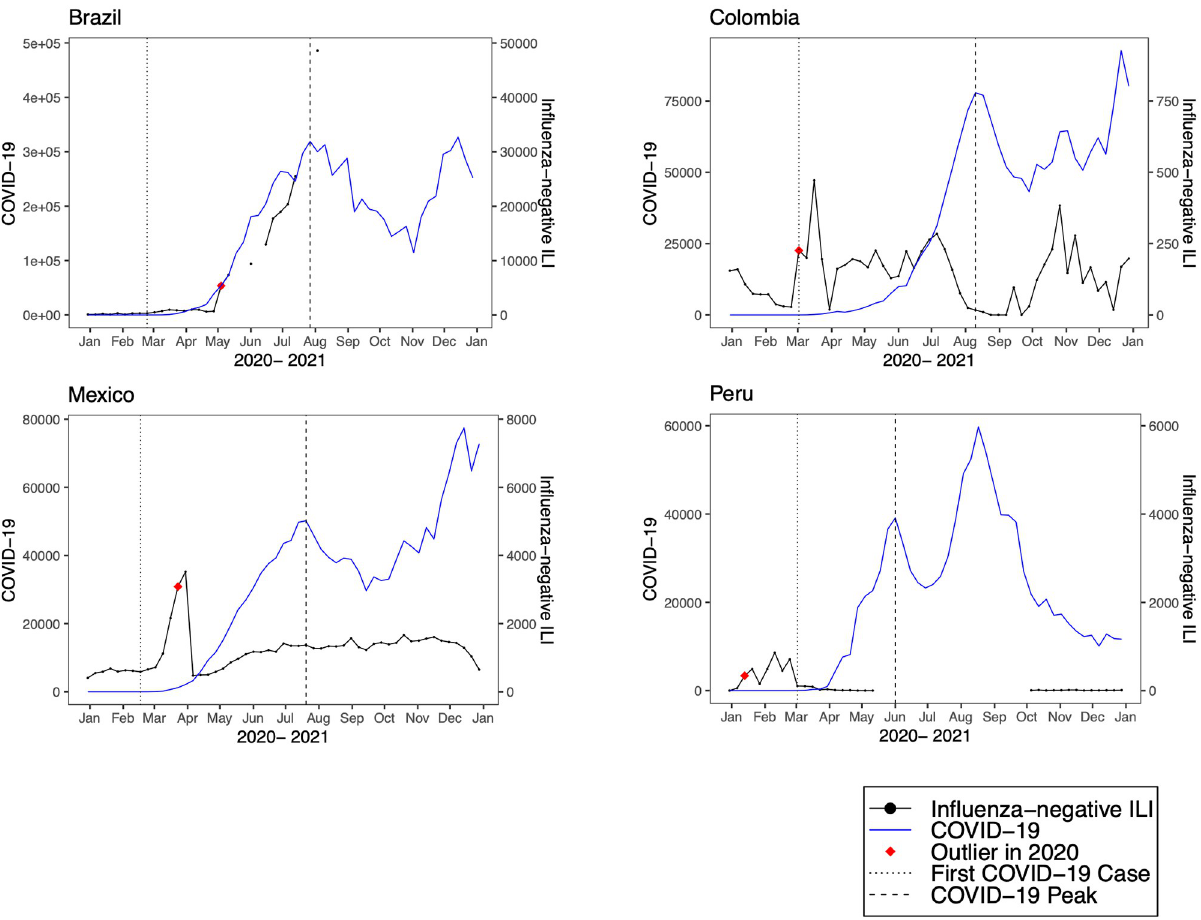
Fig 6. Observed trends in COVID-19 compared to influenza-negative influenza-like illness (ILI) in upper-middle-income countries. Trends in reported COVID-19 cases (blue line) and influenza-negative ILI cases (black line) during 2020. The vertical dotted black line indicates the week of the first COVID-19 case, the vertical dashed line indicates the week of the first COVID-19 peak, and the red diamond indicates the first detected influenza- negative ILI outlier in 2020.